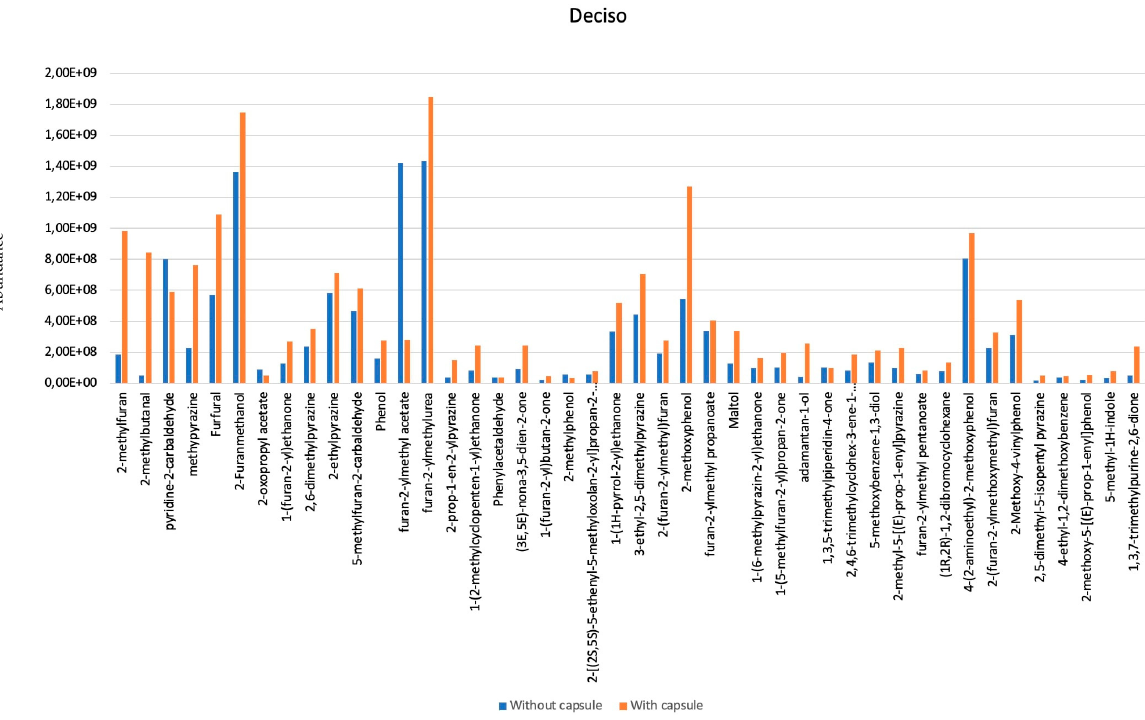
Figure 2. Comparison abundance value of common compound between Deciso coffee “with capsule” and “without cap ‐ sule”.